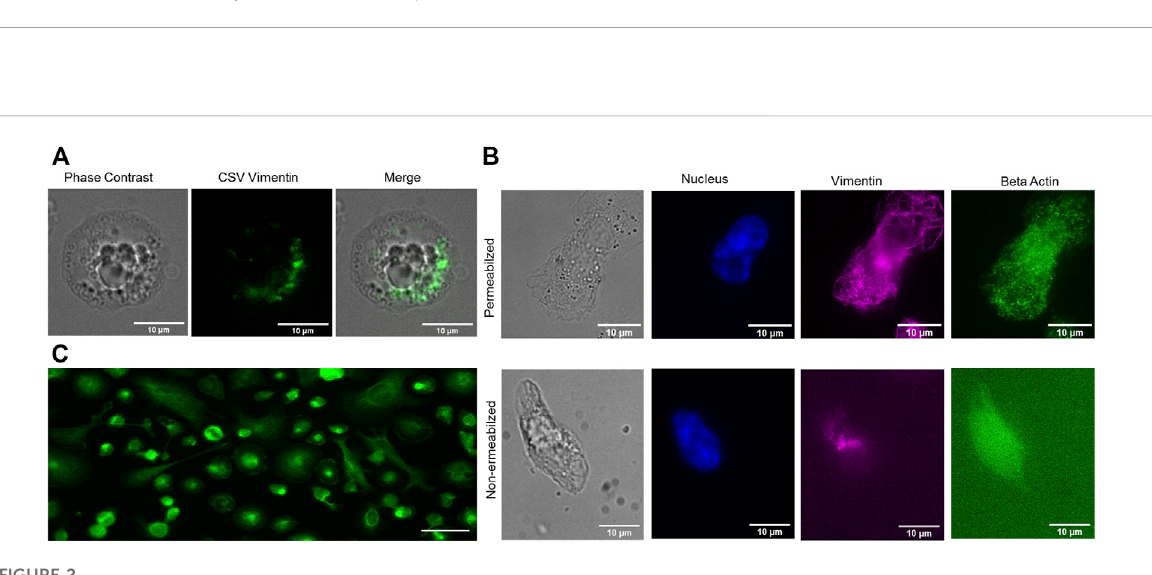
FIGURE 1 Polarised expression ofextracellularvimentin onthesurfaceof TNF- α – activated macrophages. (A) Representative HL-60cells before(left)and after (right) differentiation with TPA. (B) Representative non-permeabilised fi xed samples of macrophages (Differentiated) stained with the V9 anti- vimentinantibody,showingexpressionofvimentinontheirsurfaceafter1,3,and6 daysofTNF- α activation.Toprow:Phasecontrastimages.Middle row:Fluorescentimagesforvimentin(red).Bottomrow:Overlayofphasecontrastand fl uorescentimages.Scalebar,10 µm. (C) Quanti fi cation oftheproportionofmacrophagesexpressingextracellularcell-surfacevimentininapolarisedmanneroverthe6 daysofTNF- α activation.ndenotes the total number of cells analyzed, error bars correspond to standard deviation.